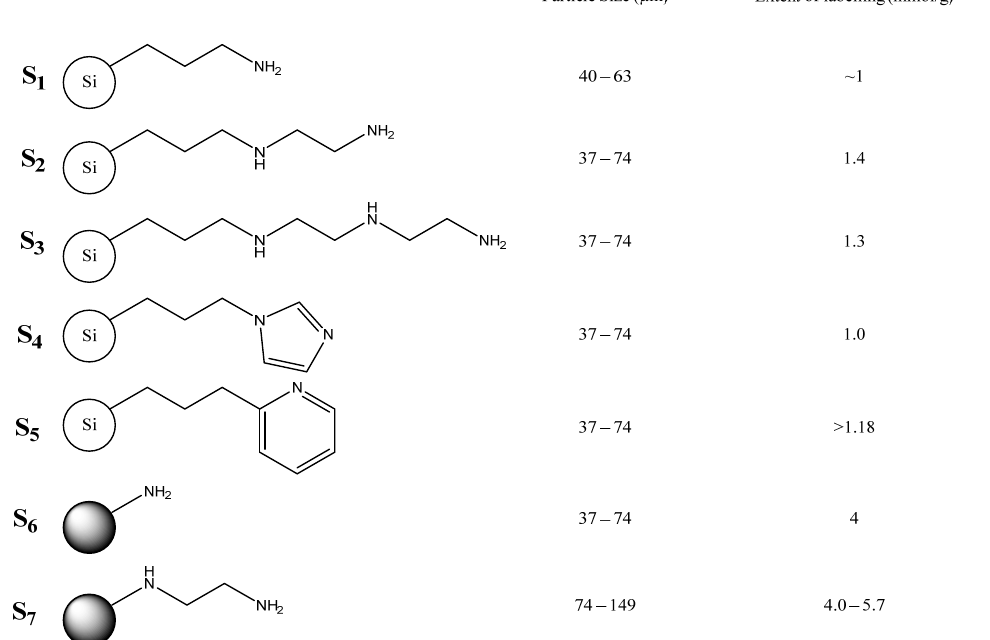
Figure 2. Scavengers tested within this work. Supports S 1 – S 5 are functionalized silica, S 6 and S 7 are functionalized polystyrene.